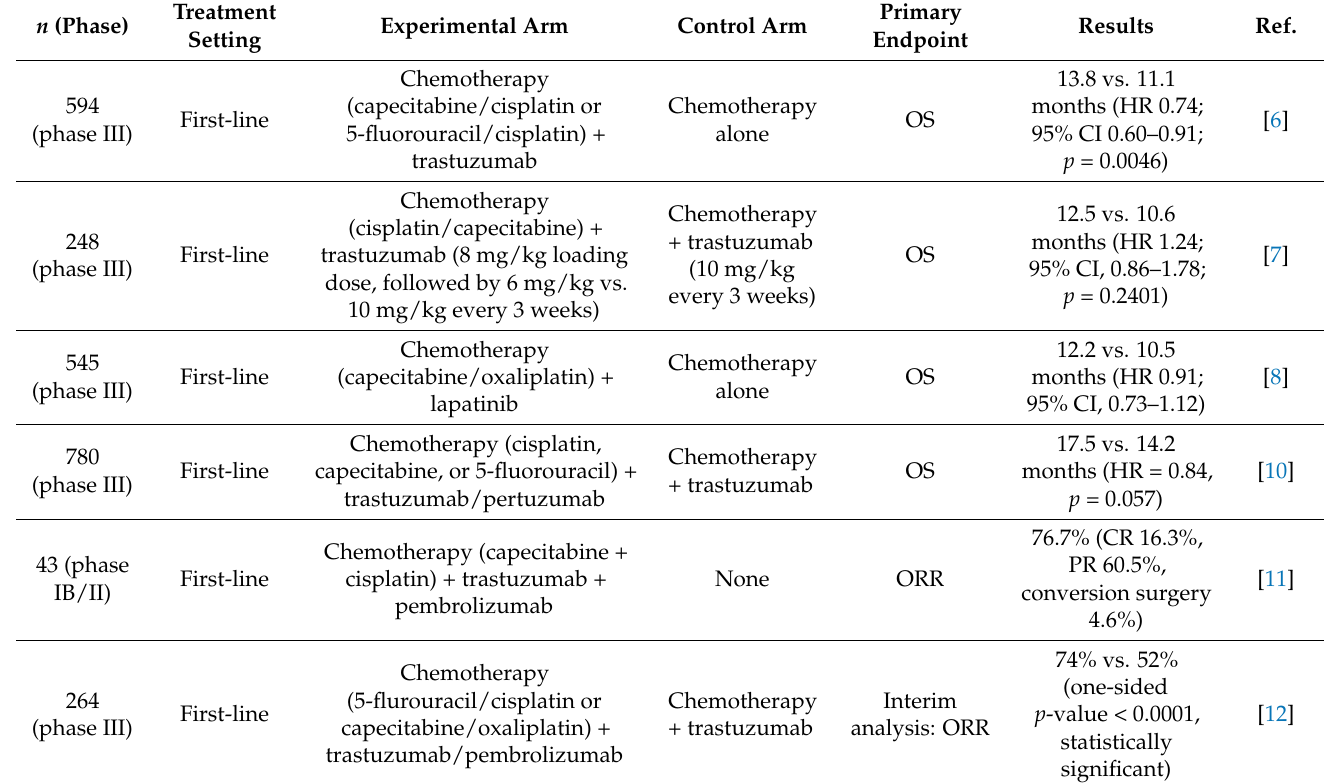
Table 1. First-line seminal clinical trials of HER2 targeted therapies in HER2-positive advanced gastroesophageal